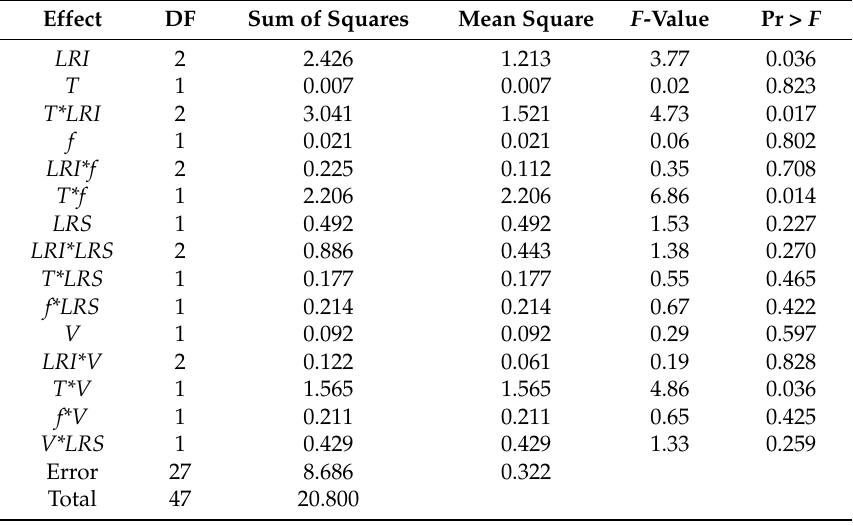
Table 7. Outcome of the first iteration for the ANOVA over Ra Naperian logarithm.